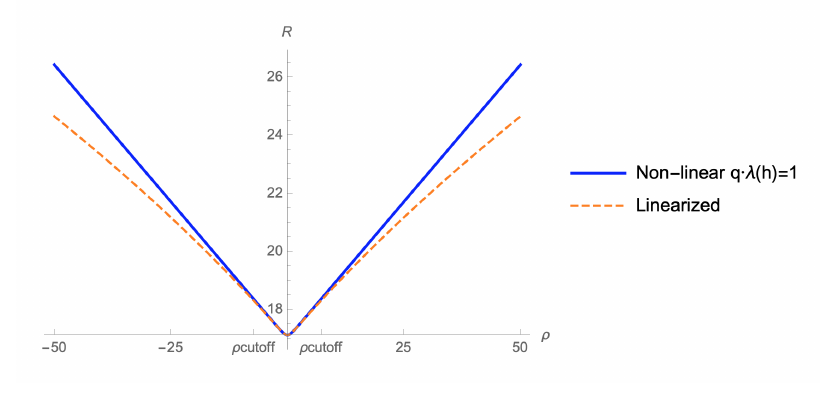
= 0 . 01 , G N qλ ( h ) = 0 . 001 , and ‘ = 100 . The g 2 ‘ 2 ‘ 2